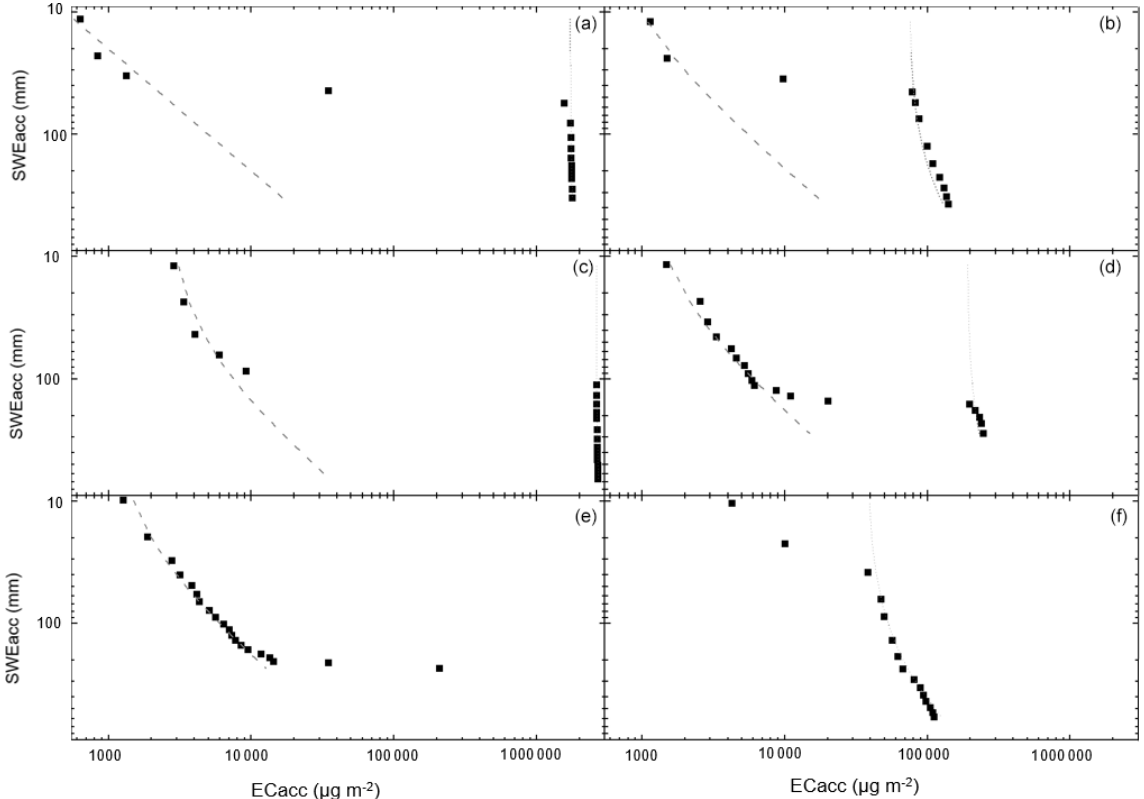
Figure 2. The cumulative EC i (EC acc ) from top to bottom in the snow pits as a function of accumulated d SWE lower dashed–dotted line represents a constant deposition EC ∗ o . In pit E there were no snow samples classified as old snow; hence there is no EC ∗ o line, while in pit F there were no young-snow samples, and therefore no EC ∗ y